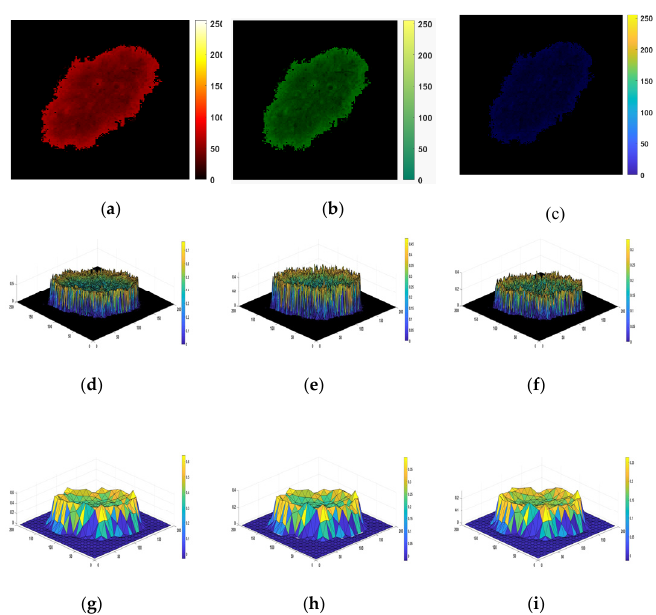
95 Figure 3. Example of measuring the color content and clustering method to select the relevant color distribution in mela ‐ nocytic lesion images. 23 color clusters, denoted as cl1, …, cl23, are presented. Data for the minimum and maximum intensity in each R, G, and B channel are indicated for each color cluster. Lower right: the segmented image. 3.2. Higuchi’s Surface Fractal Dimension (HFD) HFD is proposed as a tool for detecting and classifying skin lesions based on the complexities present in the images. The Higuchi algorithms run from the minimal scale k